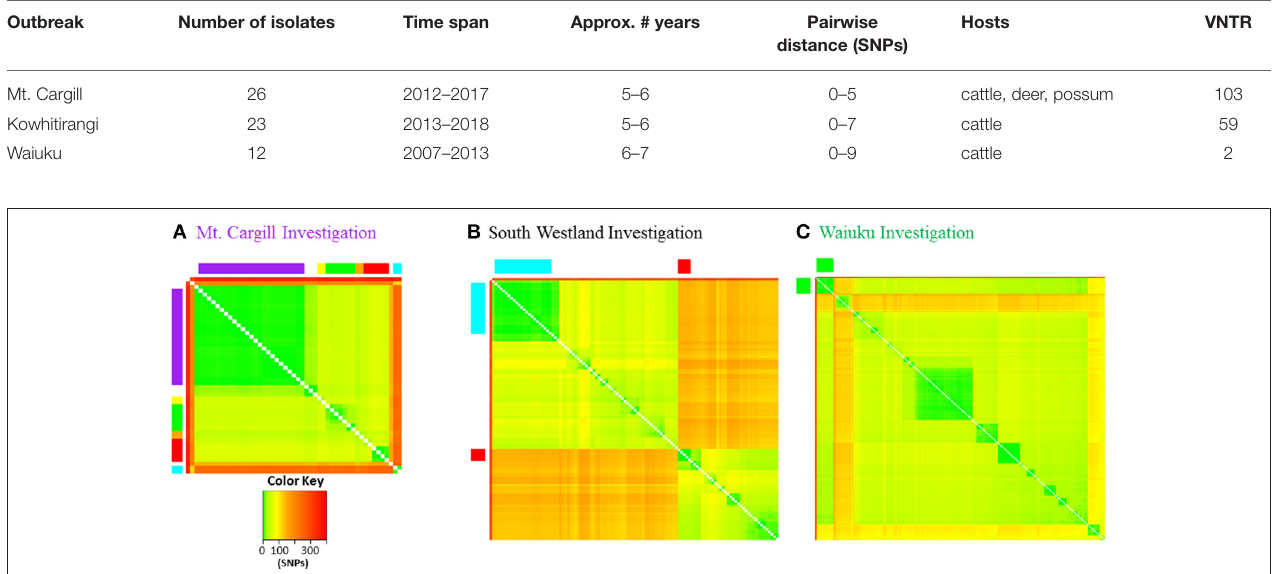
TABLE 1 | Pairwise genomic distances of epidemiologically linked isolates.